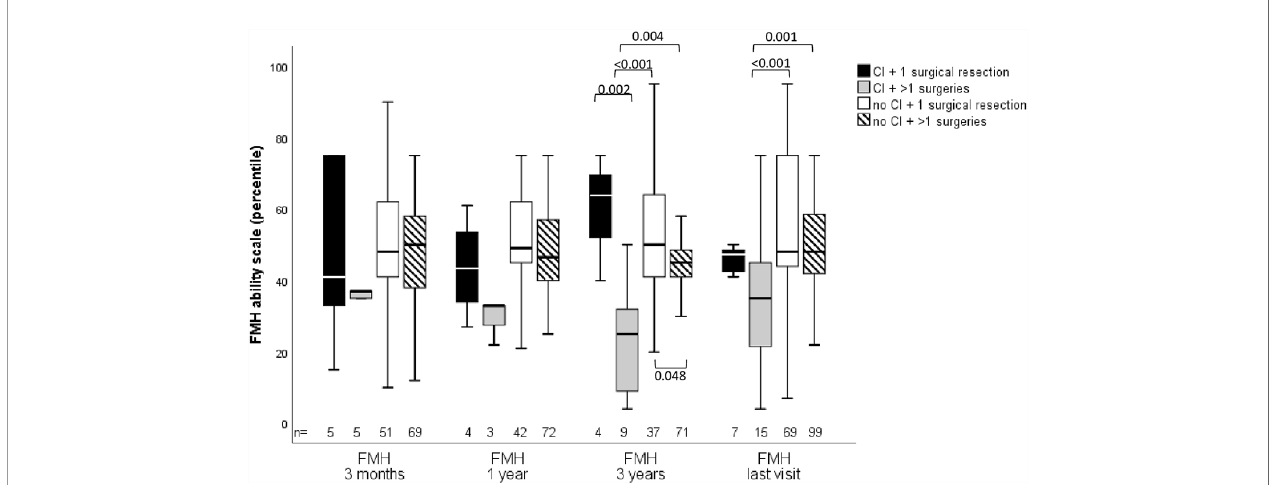
FIGURE 4 | Functional capacity as measured by capability scale Fertigkeitenskala Münster Heidelberg (FMH) in childhood-onset craniopharyngioma (CP) patients (recruited in KRANIOPHARYNGEOM 2007 between 2007 and 2019) with or without cerebral infarction (CI) and with a single or multiple surgical interventions at the time points 3 months, one year, 3 years after CP diagnosis, and at the time of last